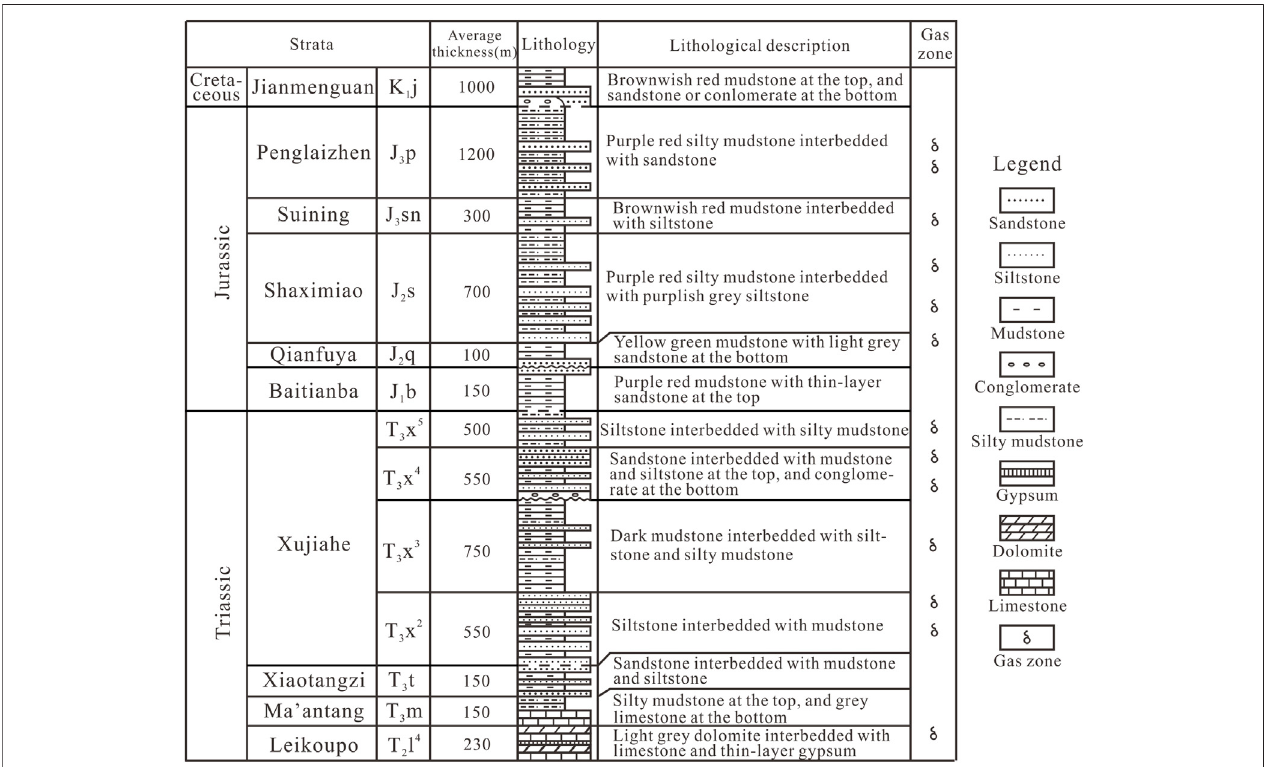
FIGURE 2 | Stratigraphic column of the Western Sichuan Depression, Sichuan Basin,